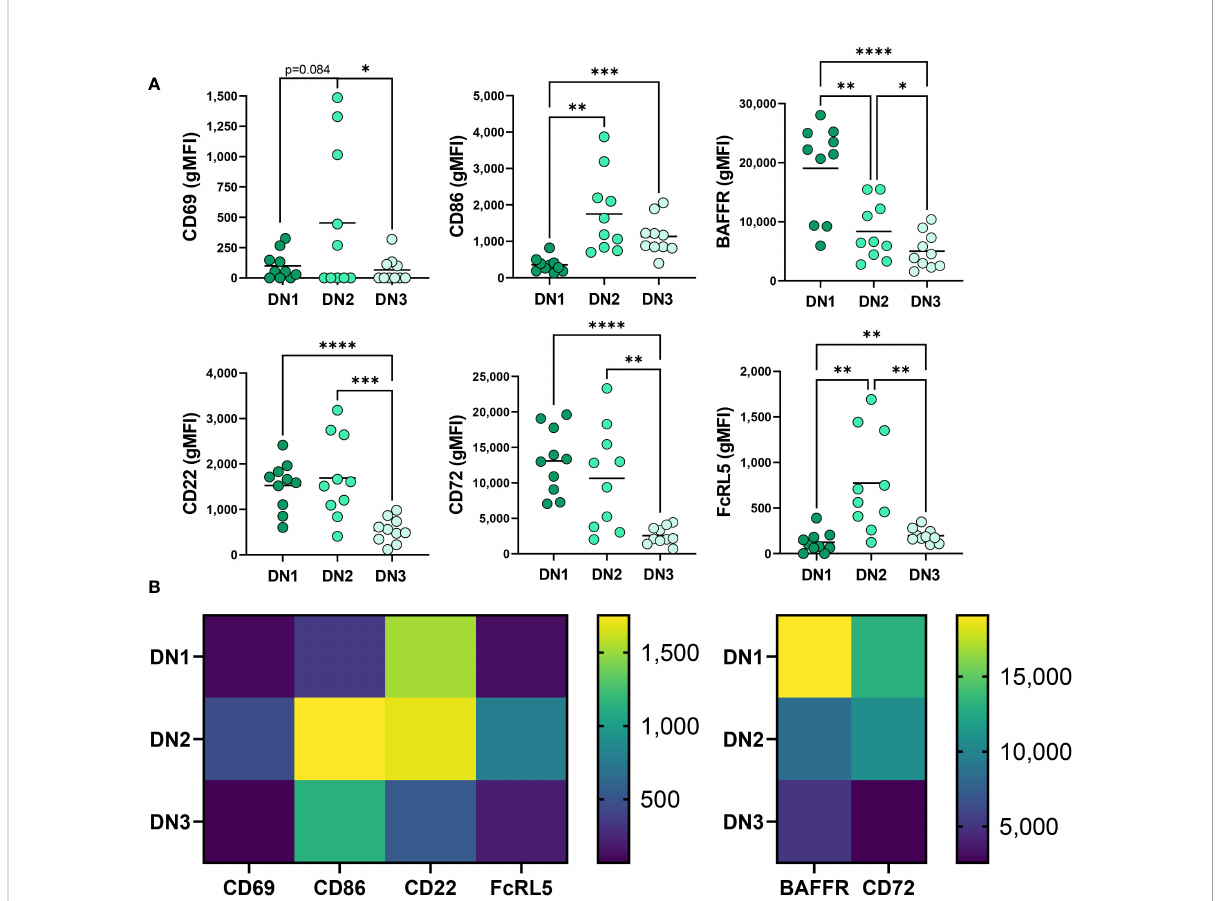
FIGURE 2 Phenotypic comparison of DN1, DN2 and DN3 cells in healthy controls. (A) Quanti fi cation of expression level (gMFI: geometric mean fl uorescent intensity) of CD69, CD86, BAFFR, CD22, CD72 and FcRL5 on DN1, DN2 or DN3 cells from healthy controls (N=10) and (B) a heatmap visualizing the differences between DN1, DN2 and DN3 subsets of average gMFI values. Statistics: one-way ANOVA, *p < 0.05, **p < 0.01, ***p < 0.001, ****p <